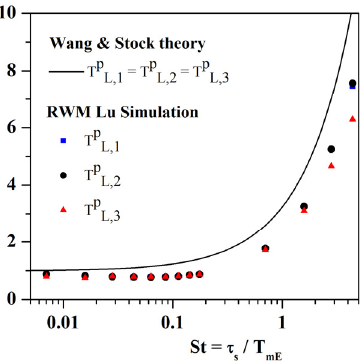
Figure 12. Normalized variance of particle velocity (g = 0).